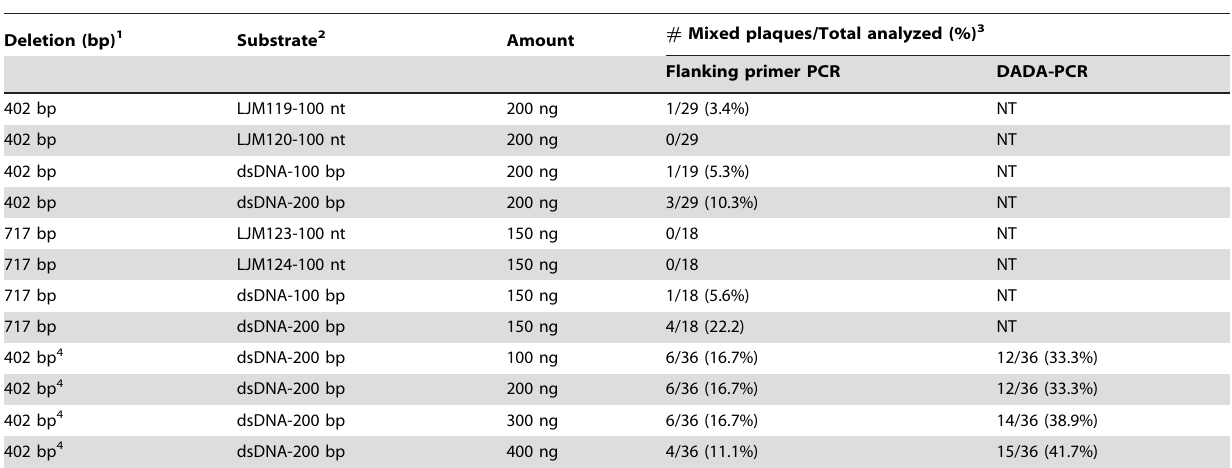
Table 1. BRED frequencies for constructing deletions in the tape measure gene of mycobacteriophage Giles.